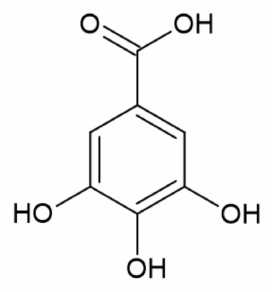
Figure 9. The structure of gallic acid [39].